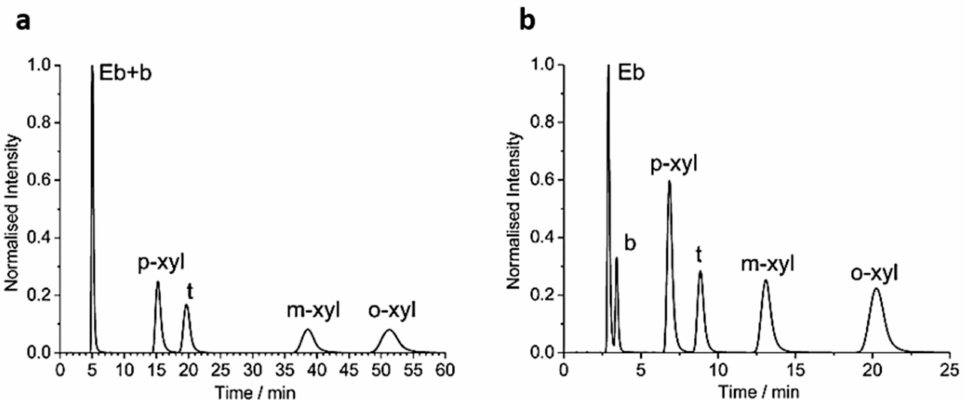
Figure 20. Chromatograms of the BTEX (benzene, toluene, ethylbenzene, and the three xylene isomers) on MIL-53(Fe) at 293 K ( a ) and 323 K ( b )